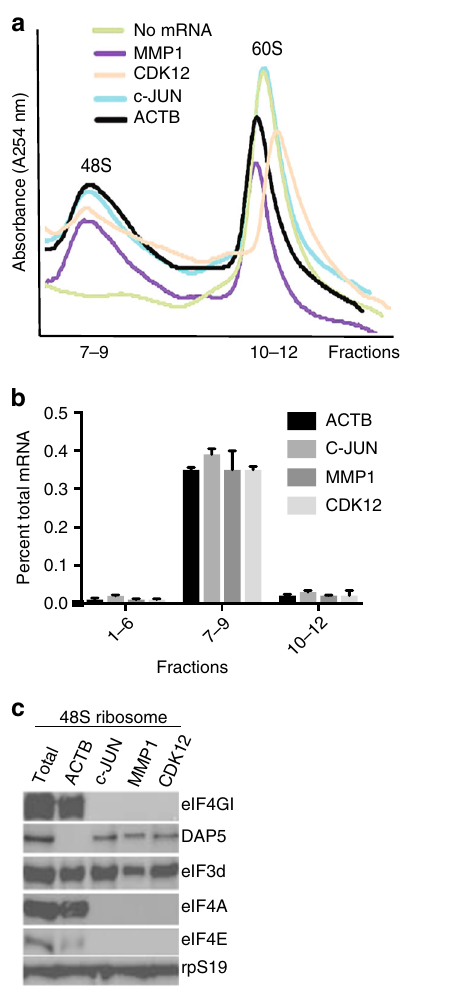
Fig. 4 DAP5 interacts with eIF3d to drive selective translation independently of eIF4E and eIF4GI. a Distribution of mRNAs encoding c-JUN, ACTB, MMP1, and CDK12 in 48S ribosome-mRNA complexes in 293T cell in vitro mRNA programmed translation extracts (see Supplementary Fig. 5 fl ow chart for methodology). In vitro translation